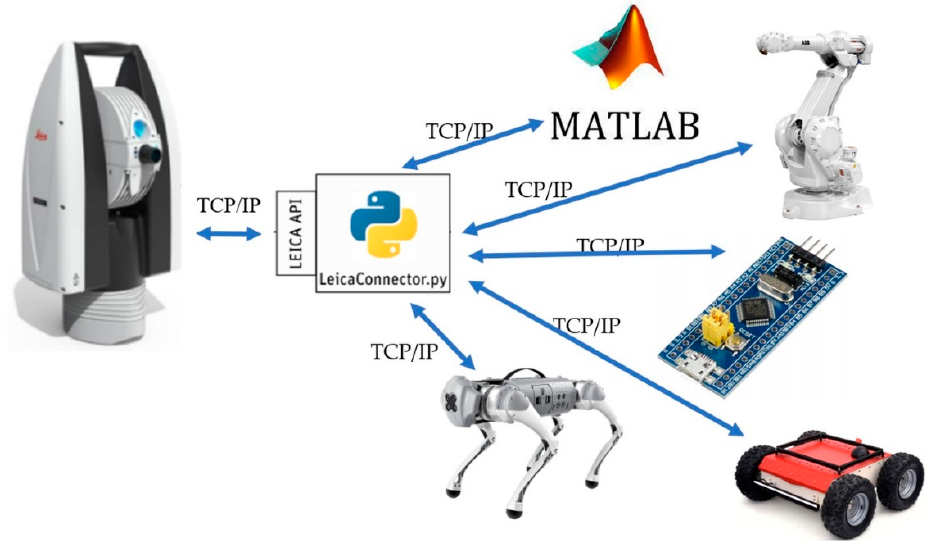
Figure 3. The concept of an intermediary program between the tracker and the end